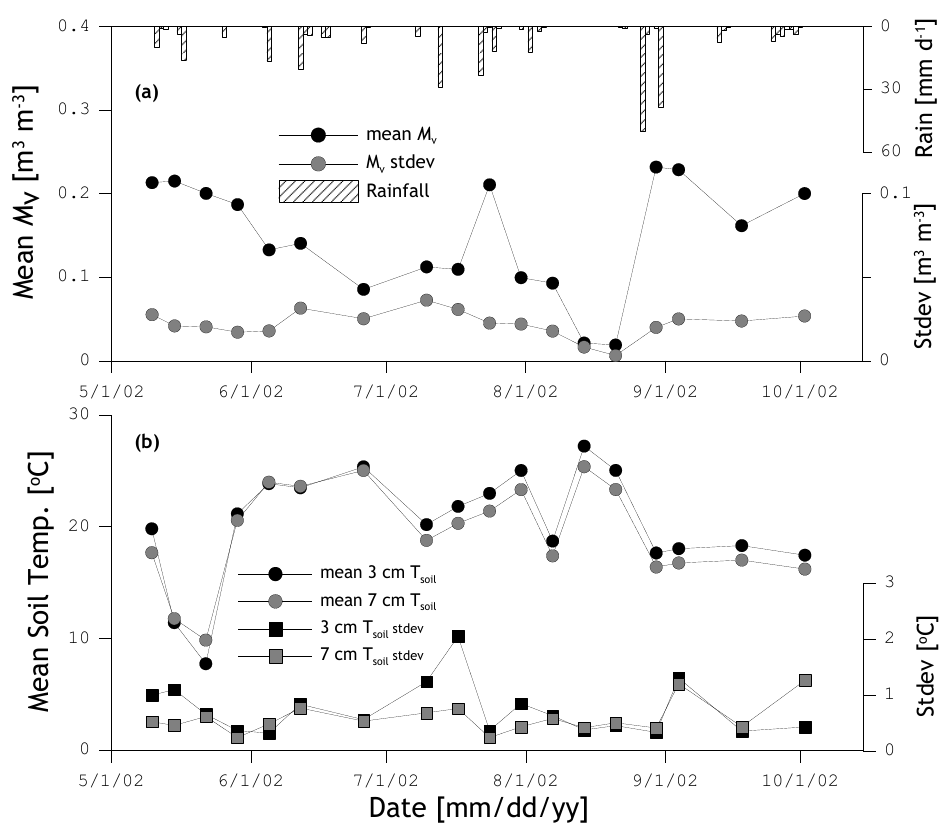
Figure 3. Mean and standard deviation of twenty-one soil moisture (a) and, 3-cm and 7-cm soil temperature; (b) measurements collected around the radiometer